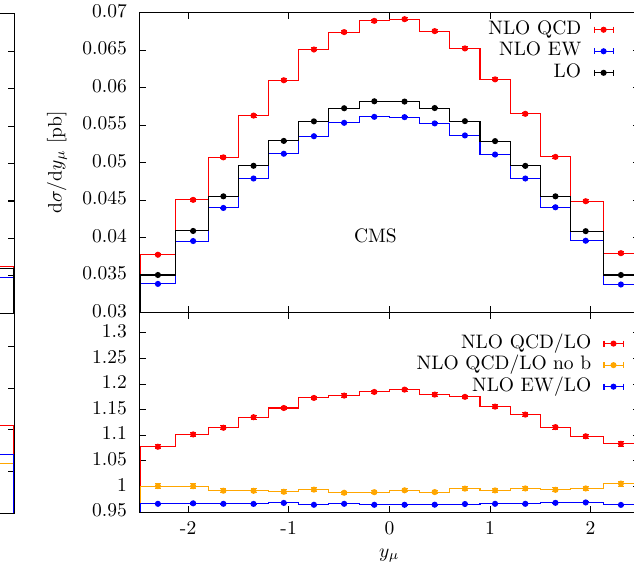
conventions as in Fig. 2. The gg channel gives a flat contribution of a √ s = 13TeV few percent and is not shown to improve the plot readability